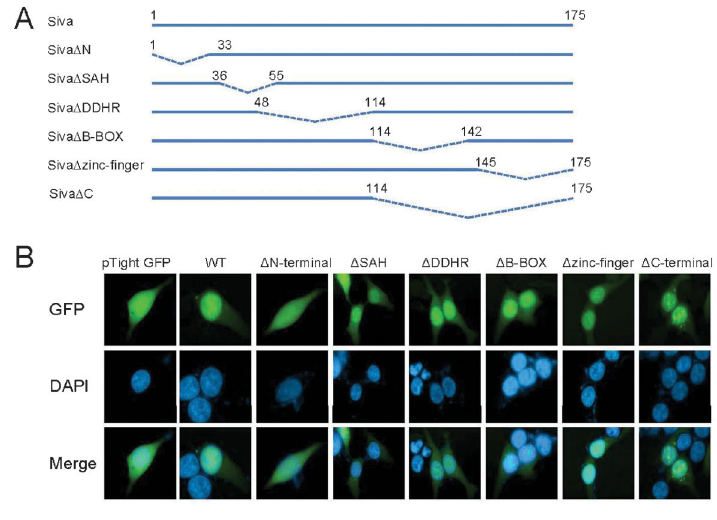
Figure 1. N-terminal is essential for Siva-1 nuclear localization. A , Structures of Siva-1 and different deletion mutants of Siva-1. Dotted lines indicate the deleted amino acid sequences within the native molecule. B , Subcellular localization of Siva-1 and Siva-1 domain deletion mutants in 293T cells as observed by fluorescence micro- scopy. GFP: green fluorescent protein; WT: wild type; SAH: Siva amphipathic helical region; DDHR: death domain homology region; B-BOX: B-Box C-H domain.